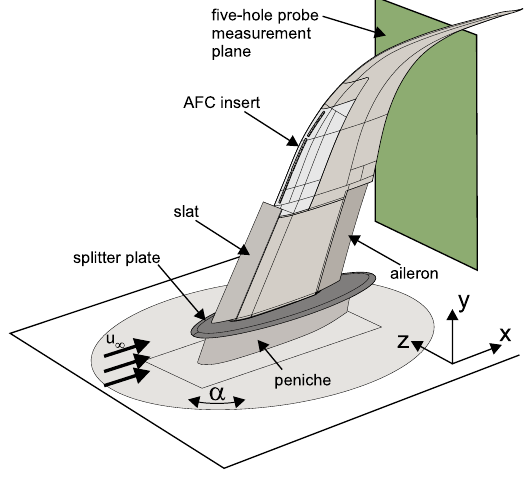
Figure 1. Sketch of wind tunnel model.